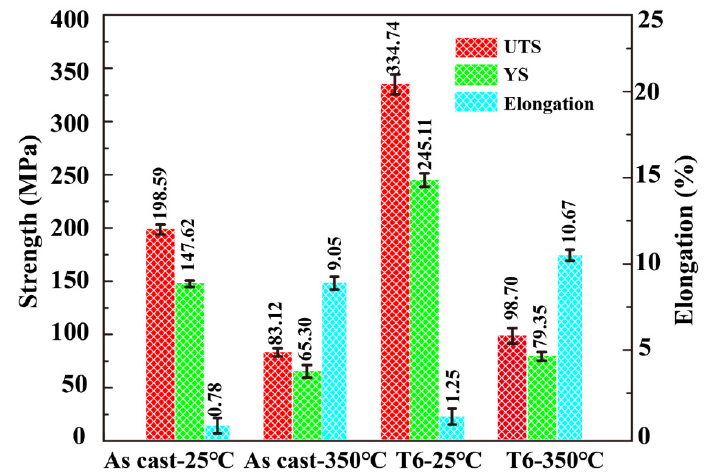
Figure 13. Tensile results for as-cast and T6 alloys at 25 ◦ C and 350 ◦ C. Table 2. Tensile properties of T6 alloys at 350 °C.